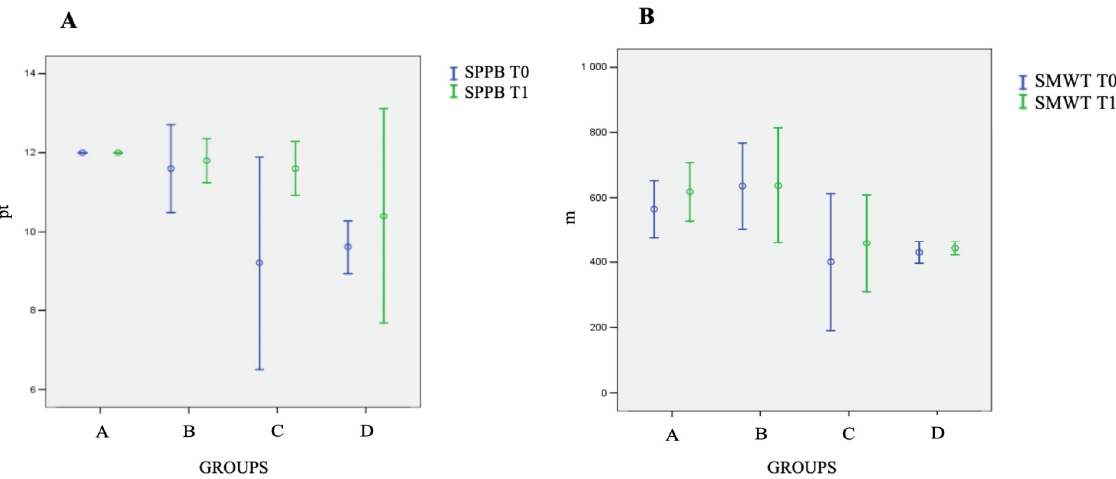
Figure 2. Results of the SPPB ( A ) and SMWT ( B ) tests in the various groups. Abbreviations: pt, points; SPPB, short physical performance battery; SMWT, six-minute walking test.